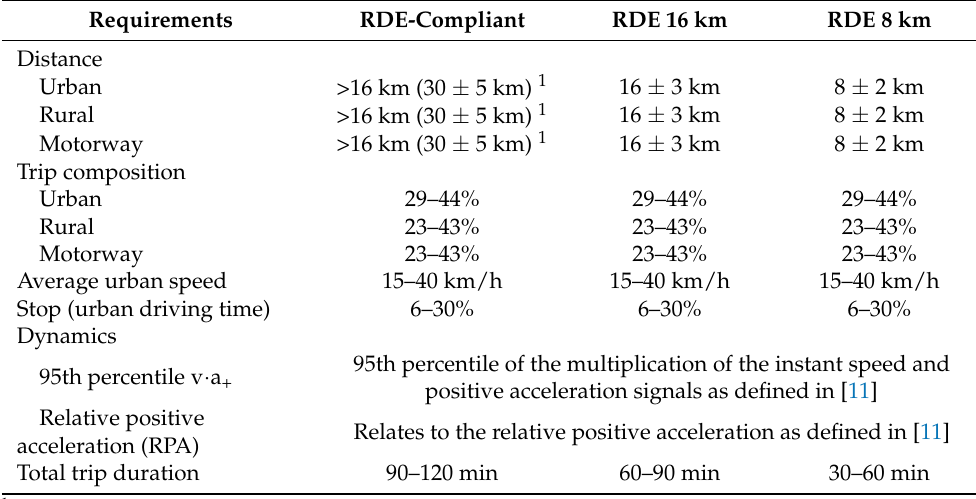
Table 2. Main characteristics of the cycles and routes (bold changes from the RDE-Compliant